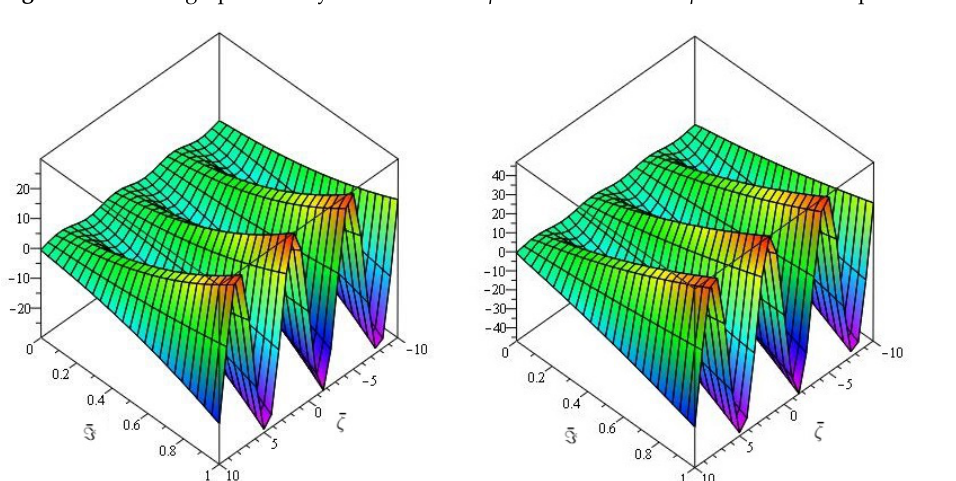
Figure 2. The first graph of analytical solution of β = 0.6 and second is β = 0.4 for Example